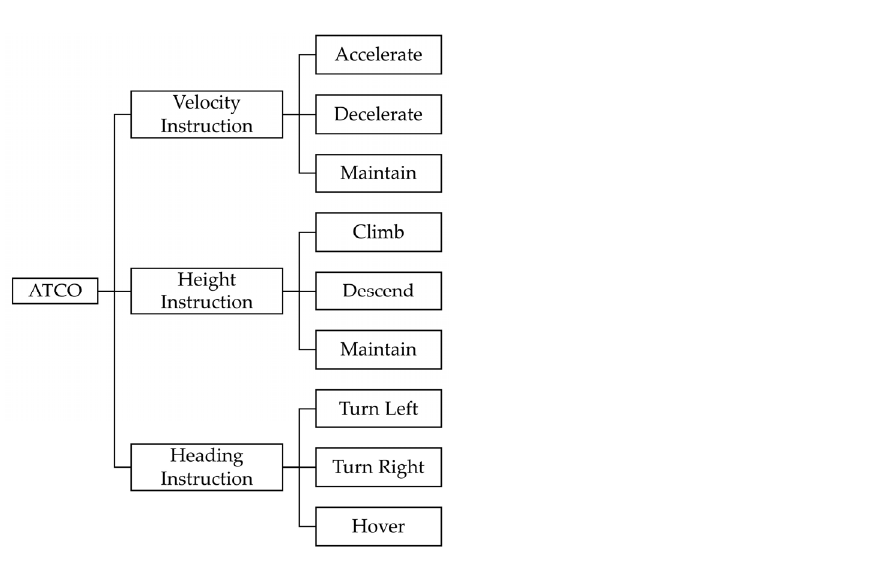
Figure 4. Coarse granulation classification of ATCOI in the proposed model.